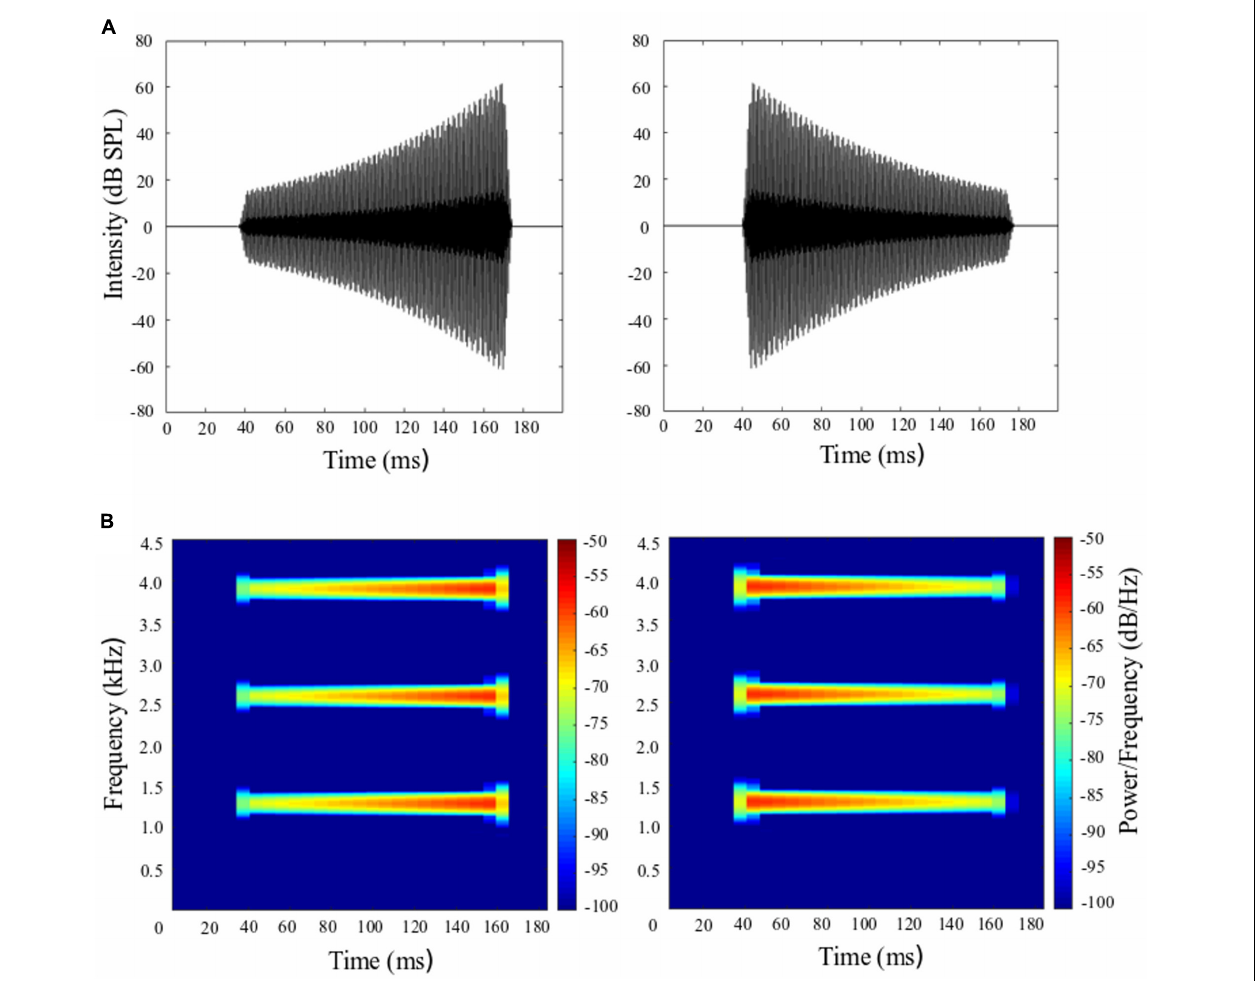
FIGURE 1 | Rising- and falling-intensity harmonic tone stimuli used in the prepulse inhibition (PPI) paradigm. (A) The waveform of looming prepulse with rising intensity from 17 to 67 dB SPL (left panel) and receding prepulse with falling intensity from 67 to 17 dB SPL (right panel) with a duration of 120 ms. (B) The frequency spectrum for looming prepulse (left panel) and receding prepulse (right